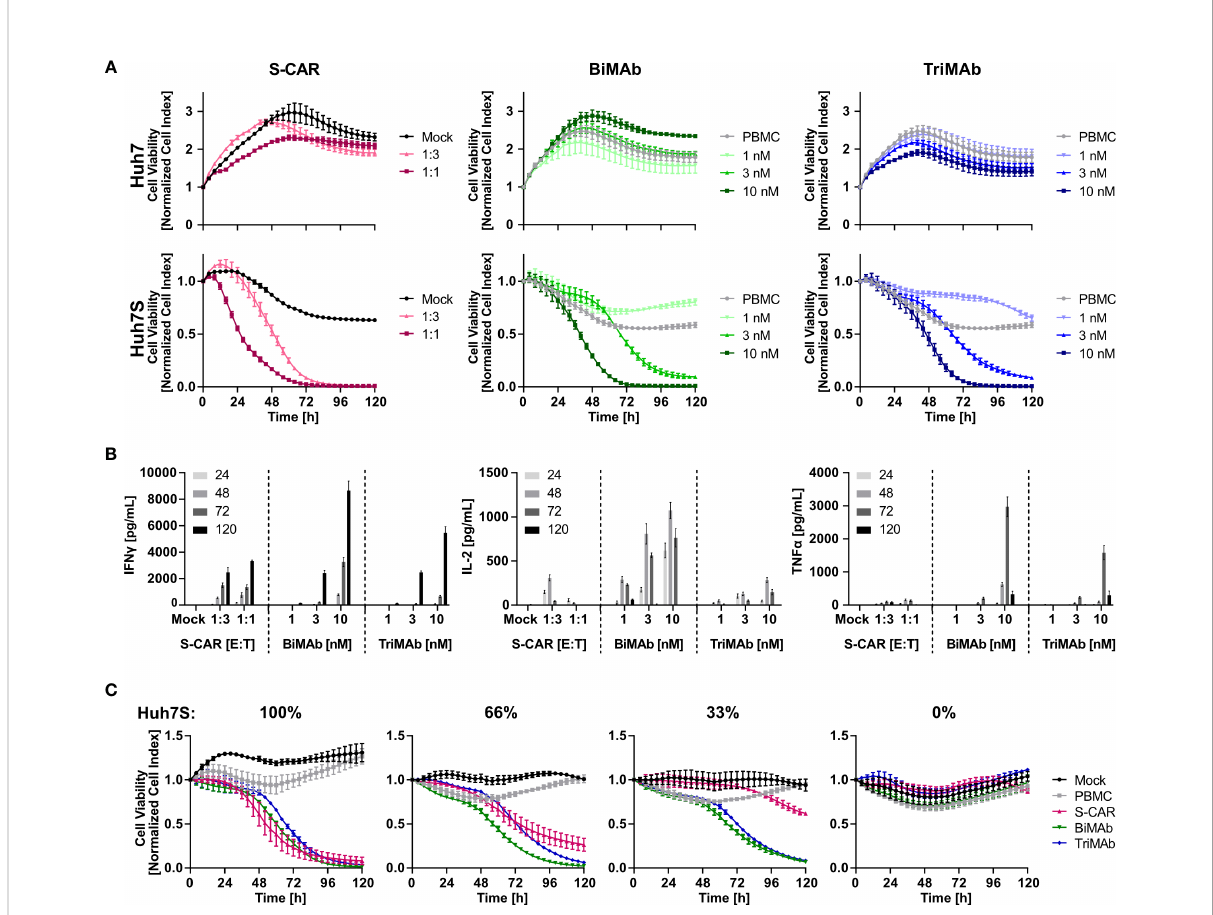
FIGURE 2 Kinetics of cytotoxicity and T-cell activation by S-CAR, BiMAb and TriMAb. S-CAR-grafted T cells at indicated E:T ratios or PBMC in combination with BiMAb a CD3 and BiMAb a CD28 in a 1:1 ratio or TriMAb at indicated concentrations were co-cultured with HBVenv-expressing Huh7S cells. Parental Huh7 cells and treatment with mock-transduced T cells or PBMC in the absence of engager antibodies served as controls. The number of PBMC was adjusted to an E:T ratio of 1:1, expecting PBMC to contain 60% T cells. (A) S-CAR T cells or PBMC in the presence of T-cell engager antibodies were co-cultured with Huh7 (upper panel) or Huh7S cells (lower panel) and target cell viability was determined in real-time by using an xCELLigence RTCA for 120 hours and plotted over time. (B) Levels of IFN g , IL-2, and TNF a in supernatant of co-cultures collected at indicated time points (hours) were quanti fi ed by ELISA. (C) Cell viability of different ratios of Huh7S cells mixed with parental Huh7 cells that were co-cultured with either S-CAR T cells at an E:T of 1:1 or antibody-treated PBMC employing 10 nM of TriMAb or CD3 and CD28 BiMAb in combination. Data represent mean values ± SD of triplicates (n =